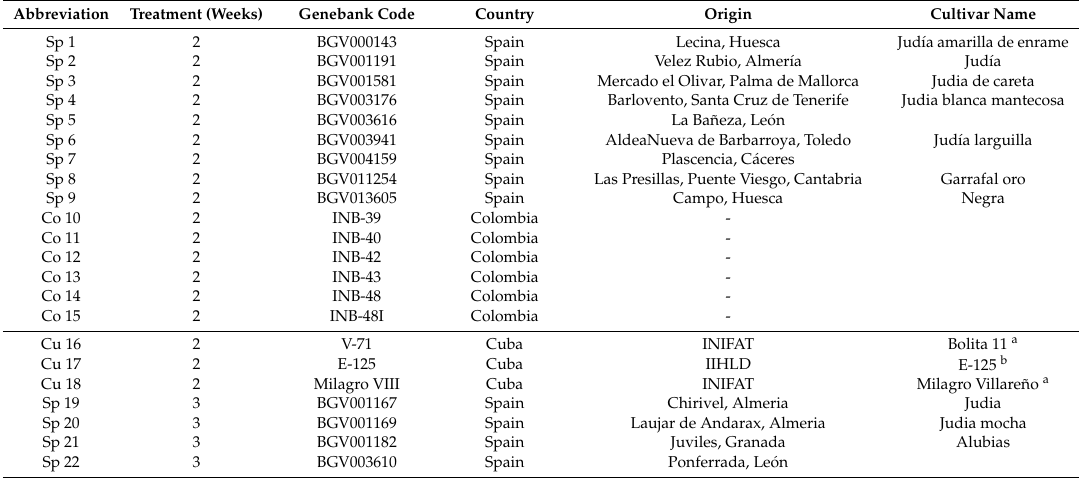
Table1. Originoftheanalysed Phaseolusvulgaris accessionsanddurationoftheappliedstresstreatments. Abbreviation